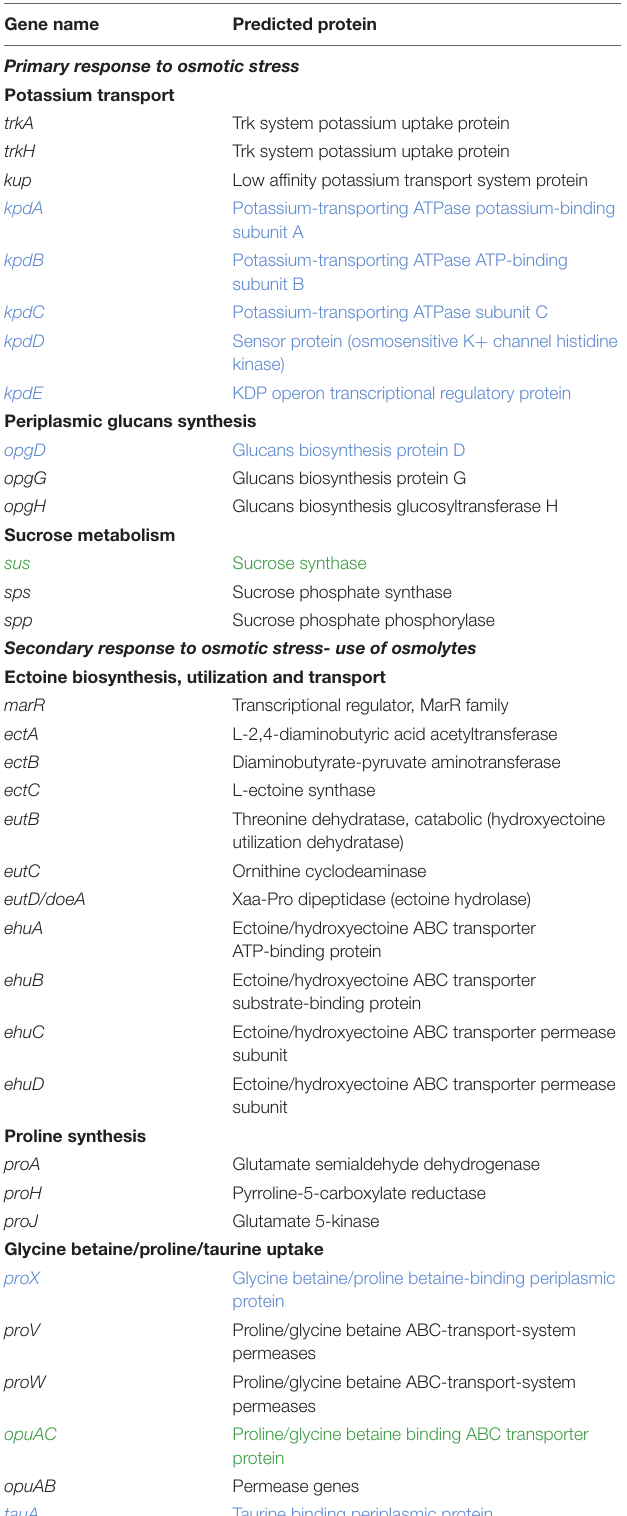
TABLE 2 | Genes and their encoded proteins with potential roles in halotolerance in members of the Acidihalobacter genus. Gene